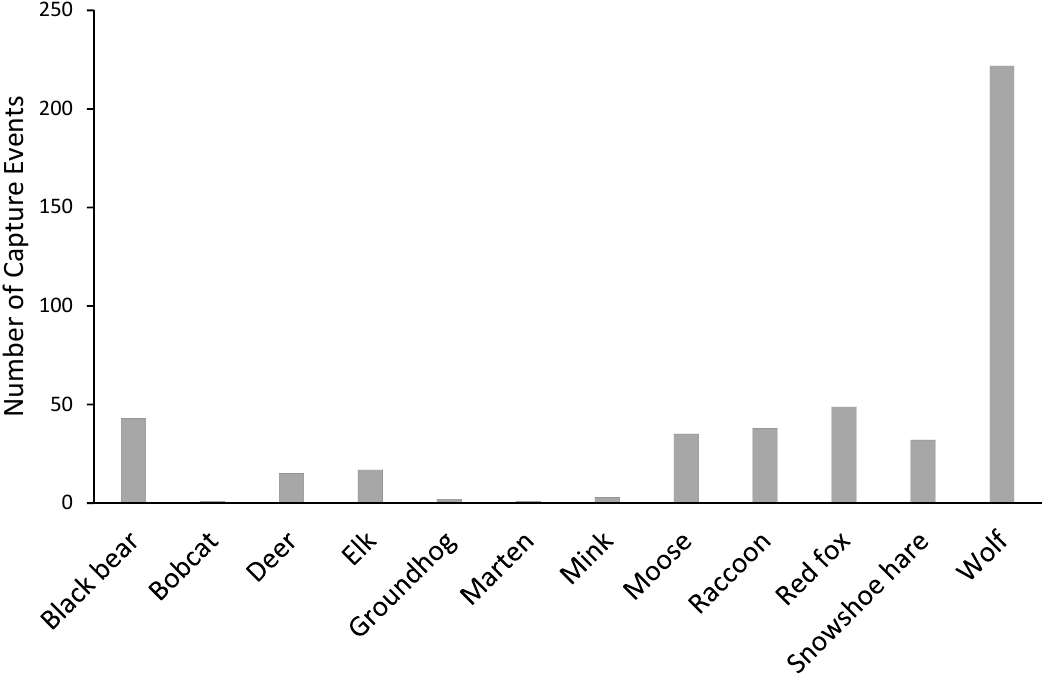
Figure 3. Mammal species capture events recorded by cameras on 20 km of the studied railway in one year (2015 to 2016).